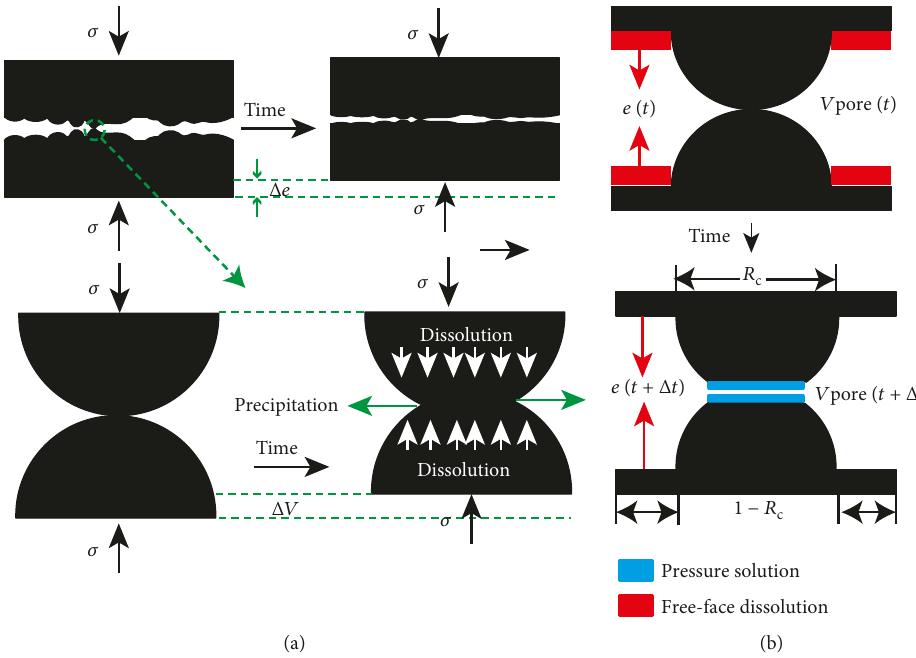
Figure 12: Schematic illustration of pressure solution in contacting asperities and free-face dissolution in noncontacting areas. (a) Pressure solution occurs in contacting asperities and decreases the fracture aperture and (b) mineral dissolution at the free face contributes to the fracture aperture